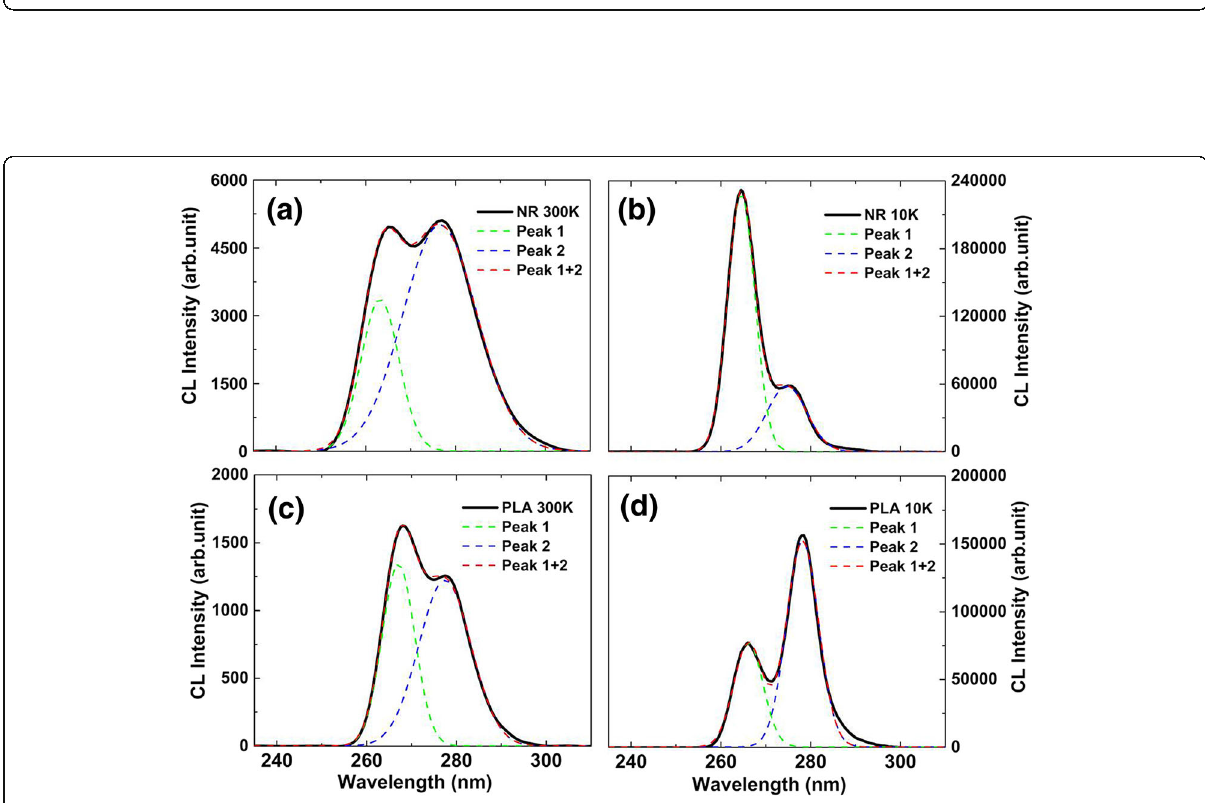
Fig. 3 a , b CL spectra of NR samples at 300 K and 10 K, respectively, excited by an electron beam (10 kV, 992 pA). c , d CL spectra of PLA samples at 300 and 10 K, respectively, excited by an electron beam (10 kV, 992 pA). The solid lines and dash lines are corresponding to the experimental and Gaussian fitting